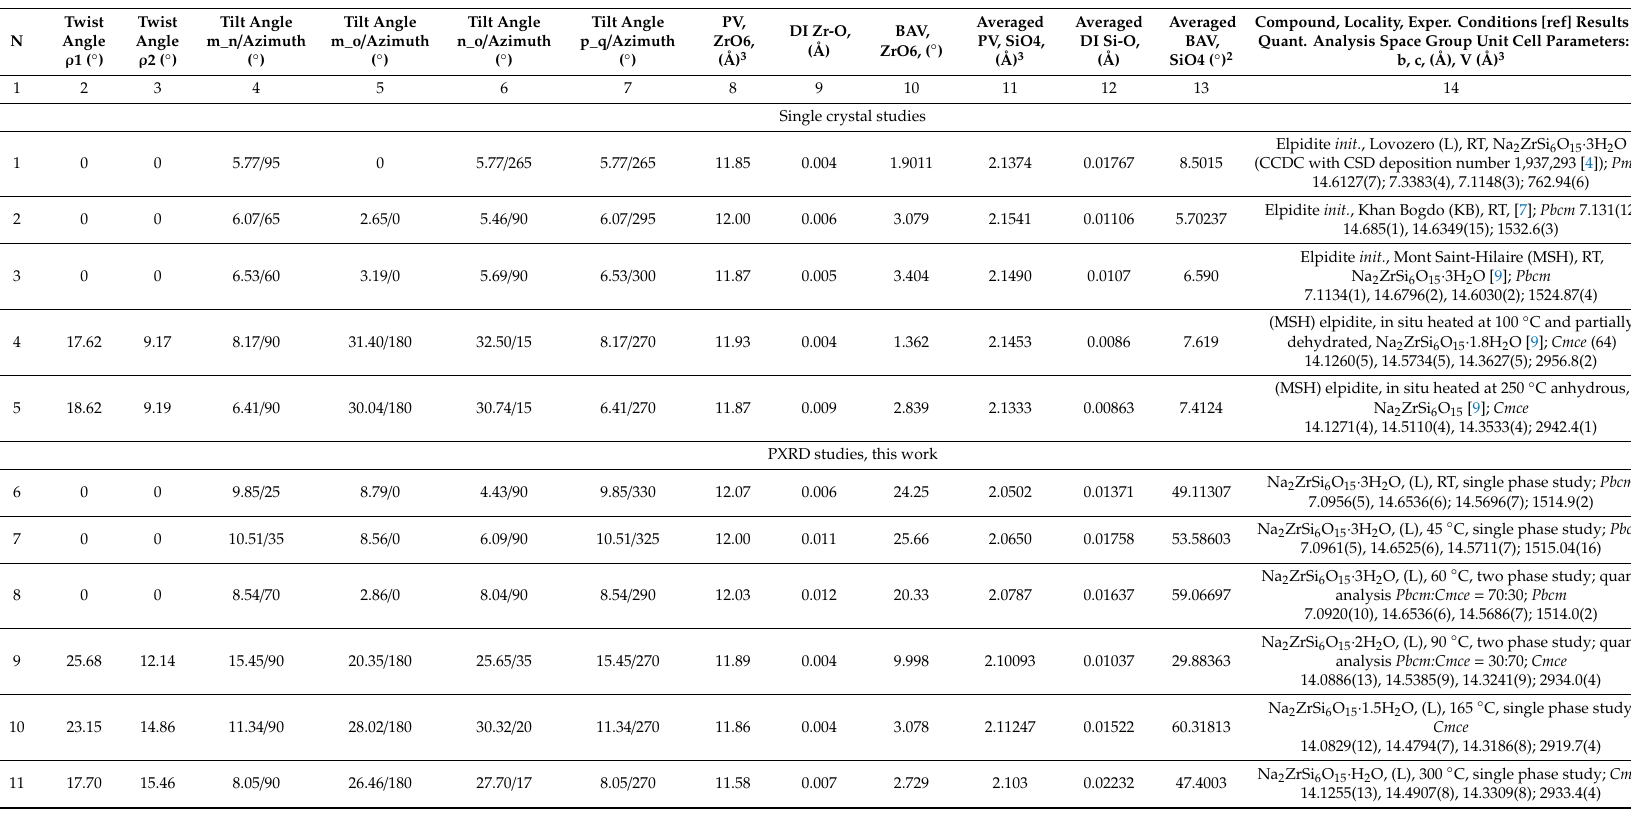
Table 5. Selected angles and distances measured for elpidite single crystals and thermally treated (RT-300 ◦ C) elpidite single crystal and powdered samples. Twist N